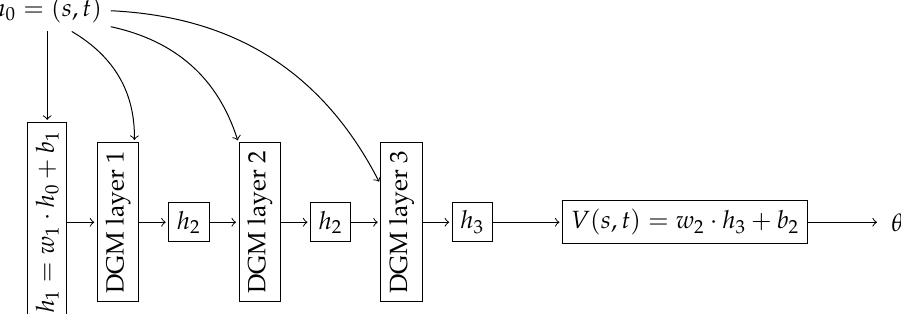
Figure 1. Block diagram showing the DGM architecture used in this work. Each DGM layer follows the implementation detailed in [10], where w i and b i denote weights and biases of the initial and final feed-forward layers. Each DGM layer is similar to an LSTM layer, as detailed in [10], and we used a dimension of 50 nodes for each of the 3 DGM layers. Note that the input is the pair ( s , t ) and the output of the neural network is the value function V ( s , t ) . We obtained the control θ using (15). After convergence, both the value function and the control approximated the optimal ones.